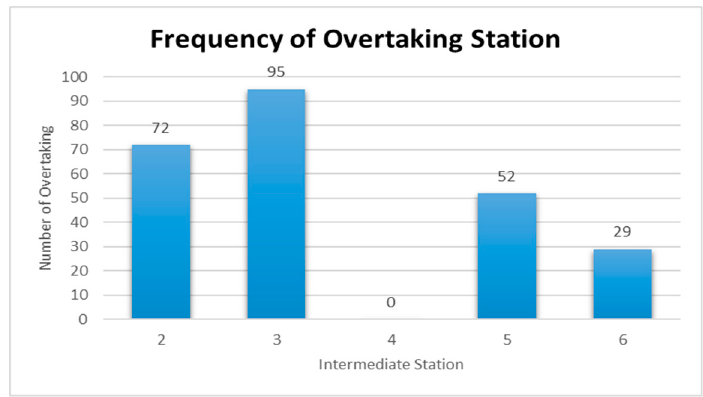
Figure 17. Frequency of Overtaking Station for Case 4.